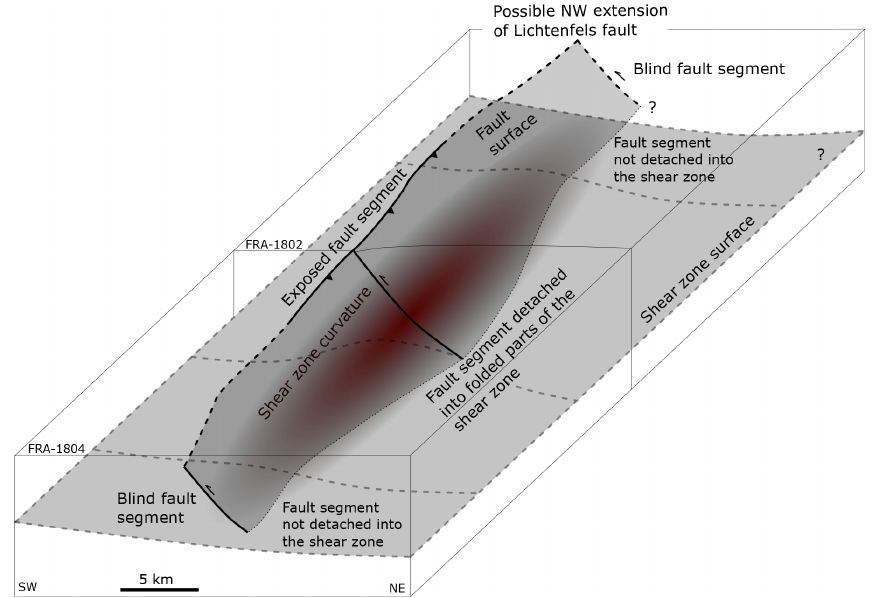
Figure 12. Cartoon showing the relationship between shear zone geometry and fault development. The dark red area in the center shows the folded part of the shear zone, where the Lichtenfels Fault portion is detached and exposed at the surface. Laterally to the SW, the shear zone is rather flat, and the Lichtenfels Fault thus does not detach and is not exposed at the